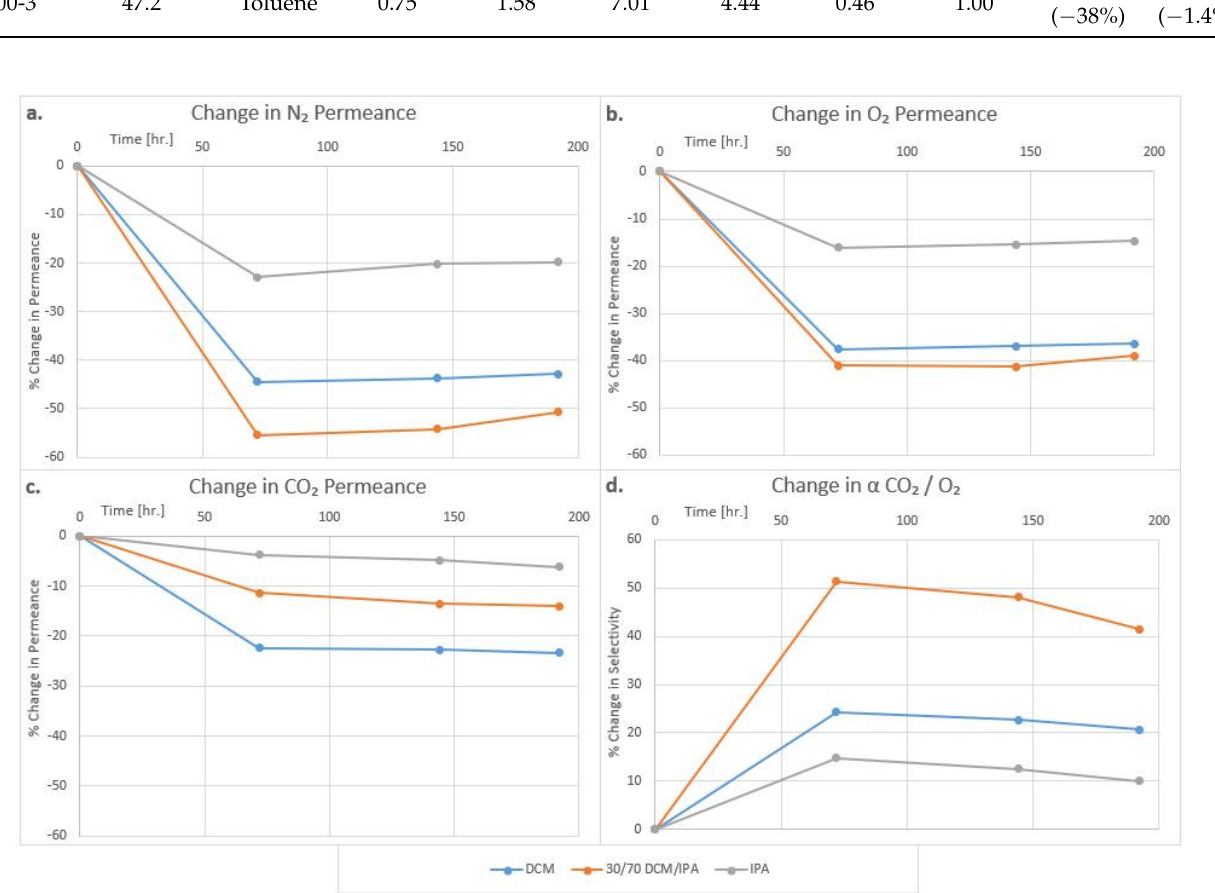
Figure 9. Effect of storing TMCTS plasma polymer coated HFM in DCM, DCM/IPA, and IPA on N 2 ( a ), O 2, ( b ) and CO 2 ( c ) gas permeance and CO 2 /O 2 selectivity ( d